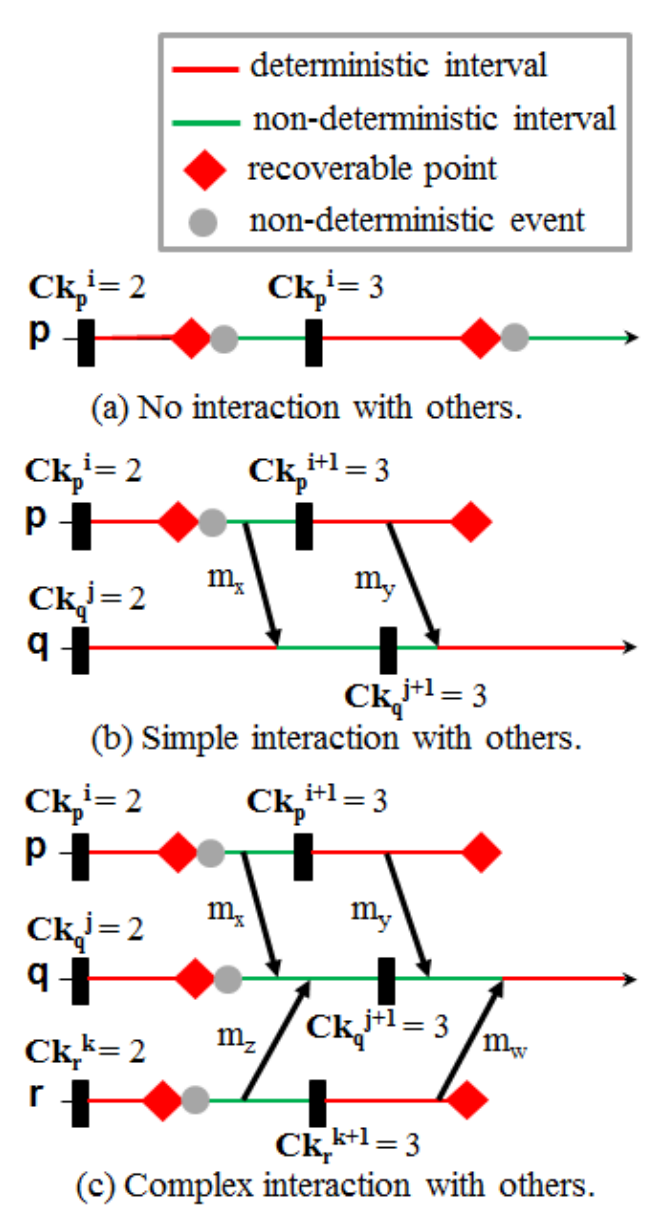
Figure 2. Three cases where the process execution mode